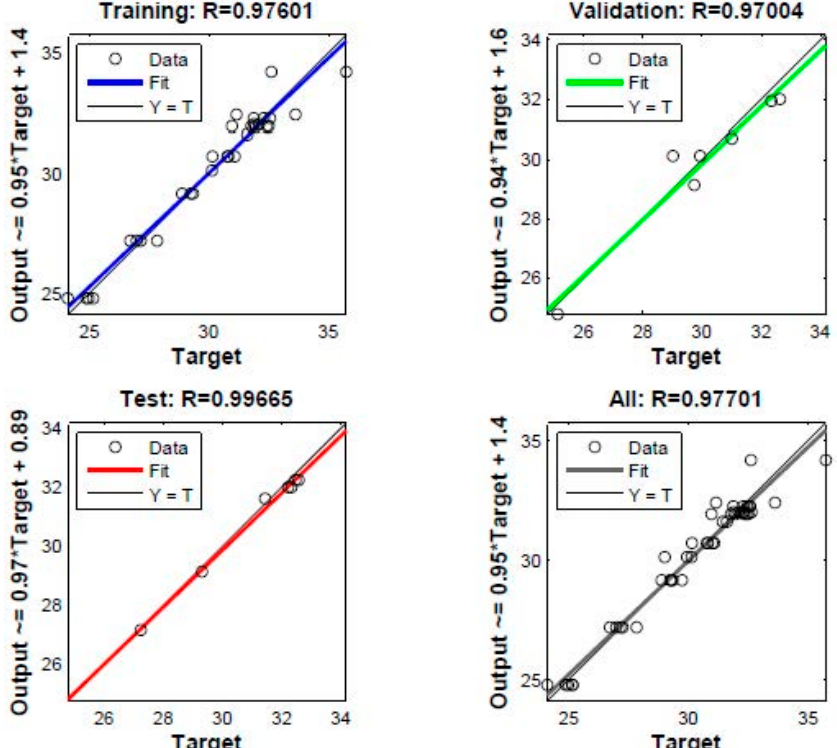
Figure 6. Prediction of strength by DNN model: regression plot.